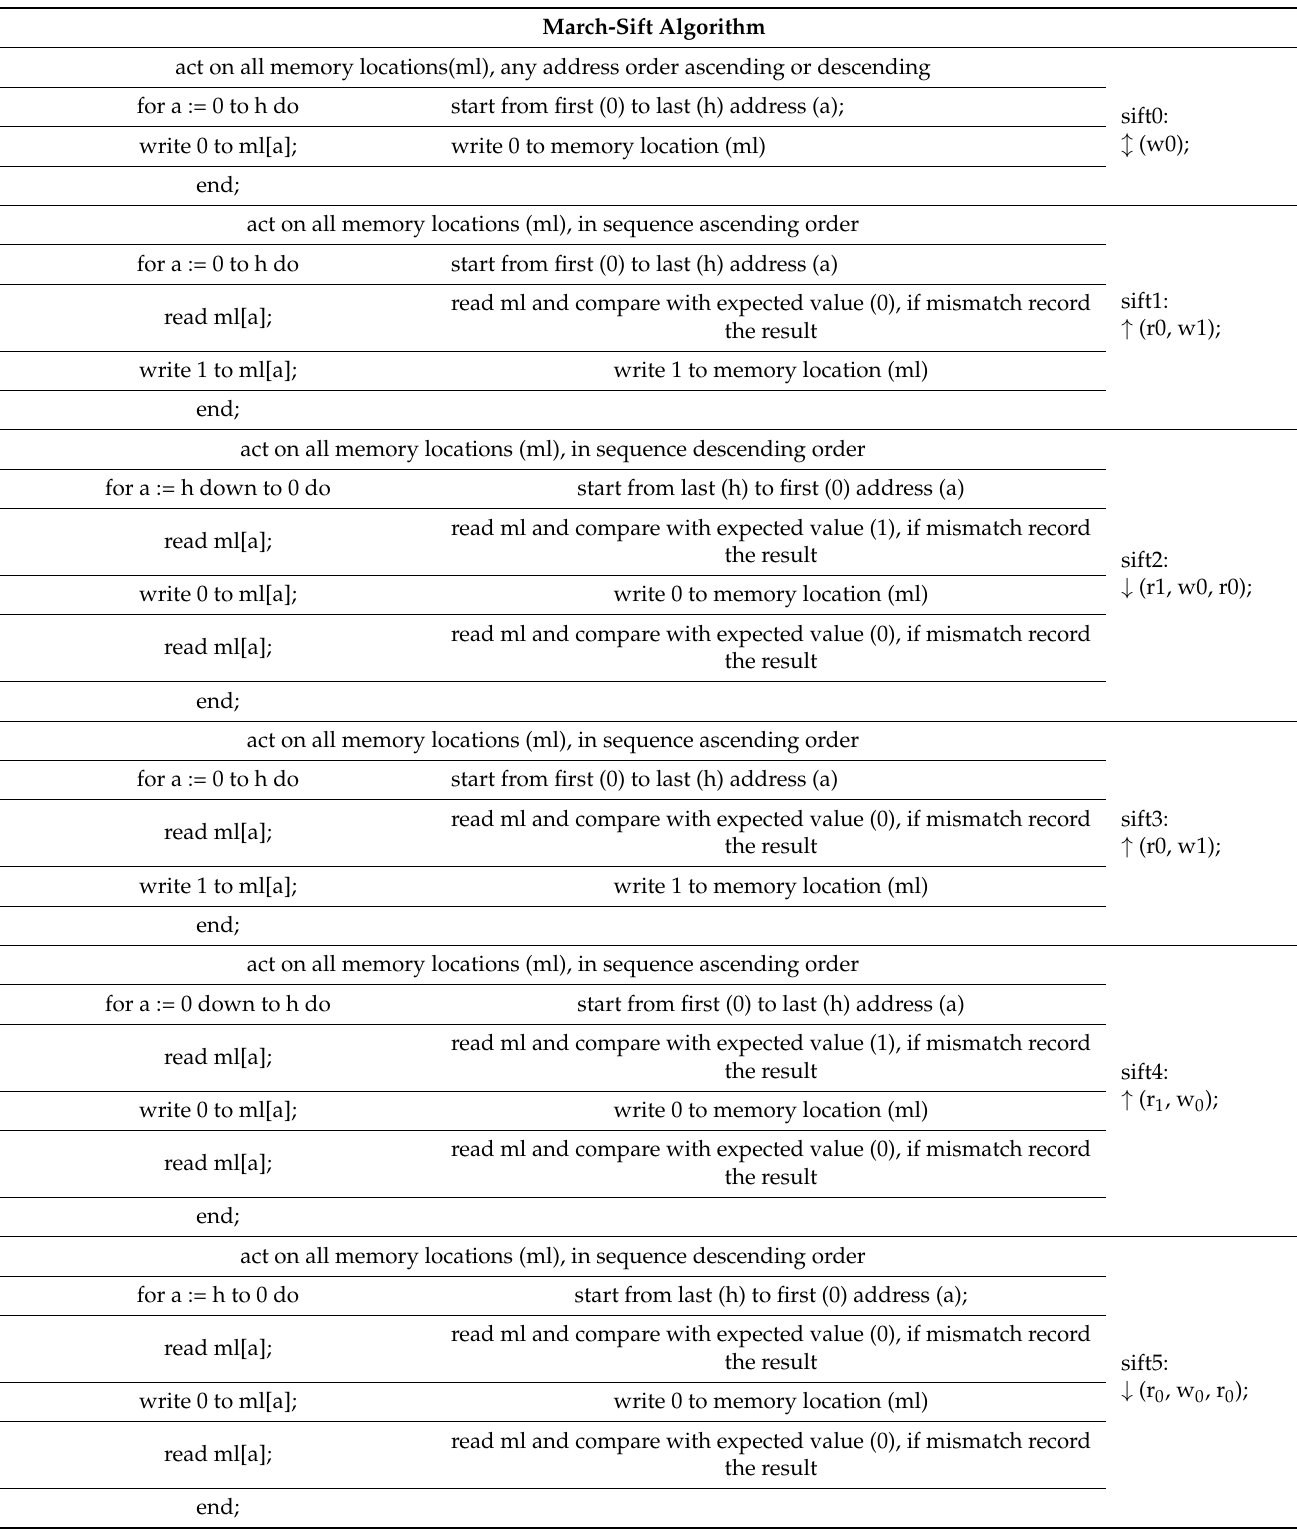
Table 1. An Algorithm. March-Sift